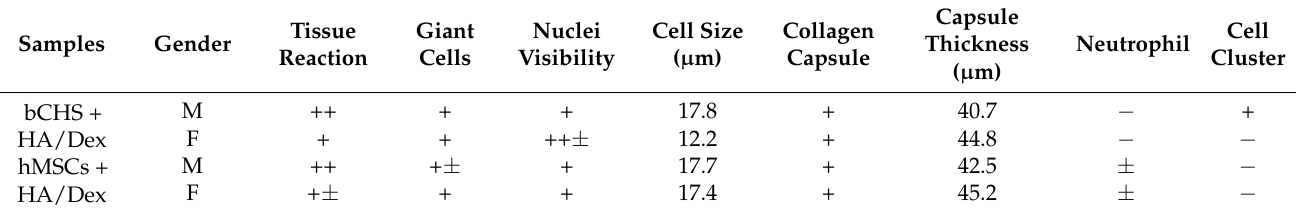
Table 2. Histological analysis of the in vivo sections from different genders.